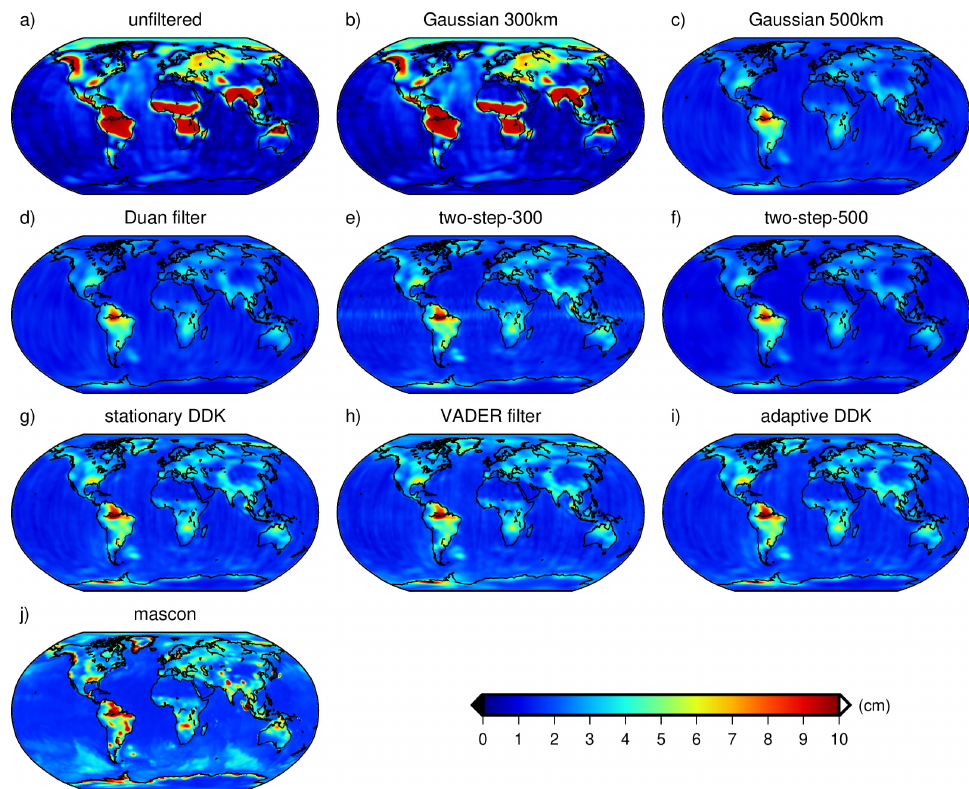
Figure 12. Annual amplitude of different filtered solutions in terms of EWH from January 2004 to December 2010. The annual amplitude is derived from annual periodic terms.